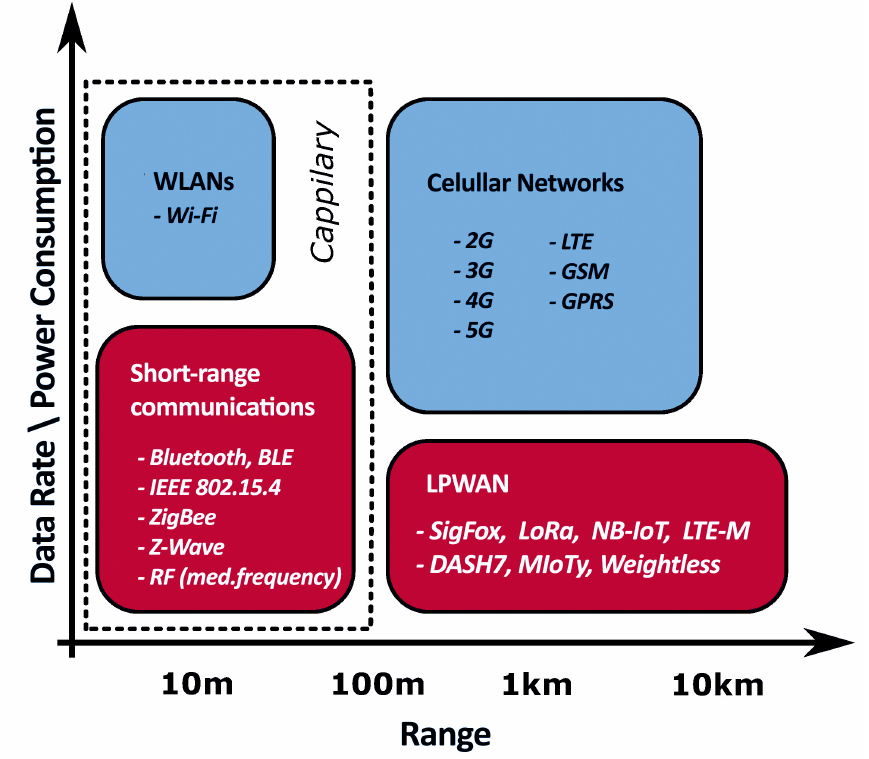
Figure 17. Comparison of network